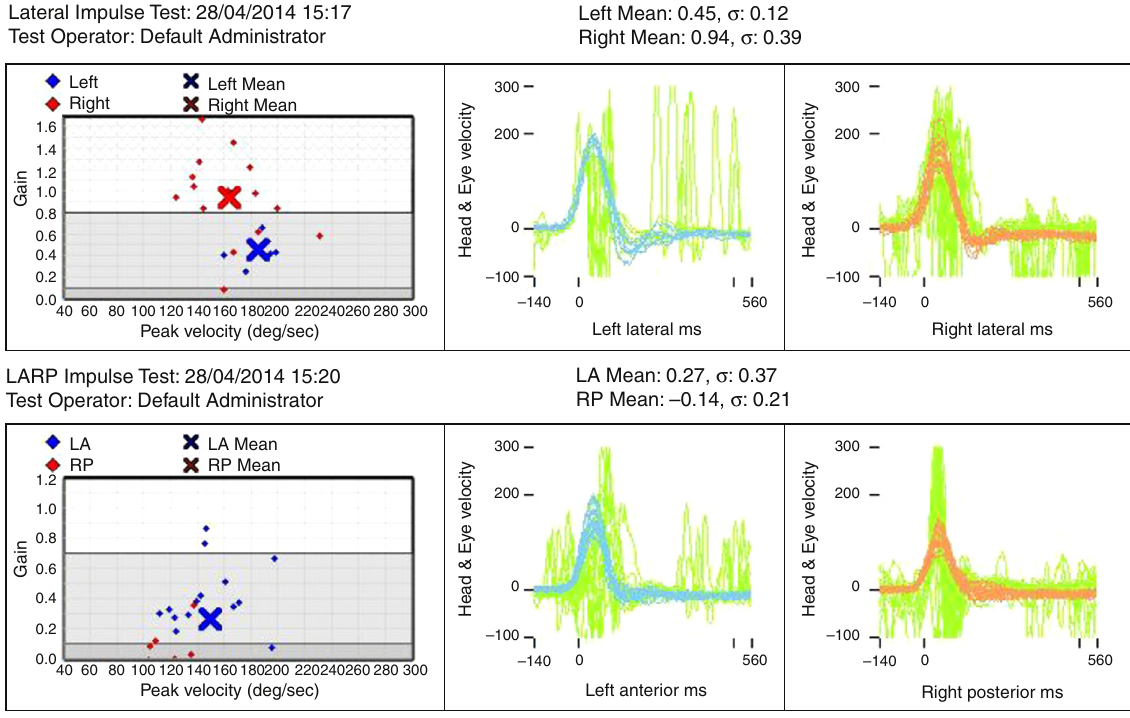
Video head impulse test showing decreased gain in left lateral and anterior channels. Left, left lateral channel; Right, right lateral channel; LA, left anterior channel; RP, right posterior